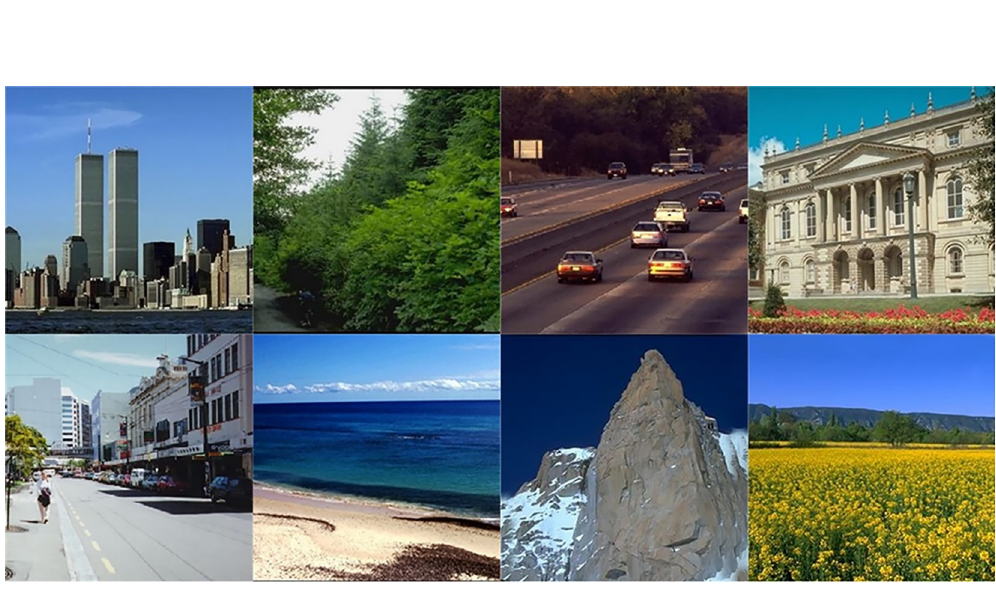
Fig 14. Top-20 retrieved images against a query image (class: Train) (reprinted from [3] under a CC BY license, with permission from J. Z. WANG, original copyright [2003]).